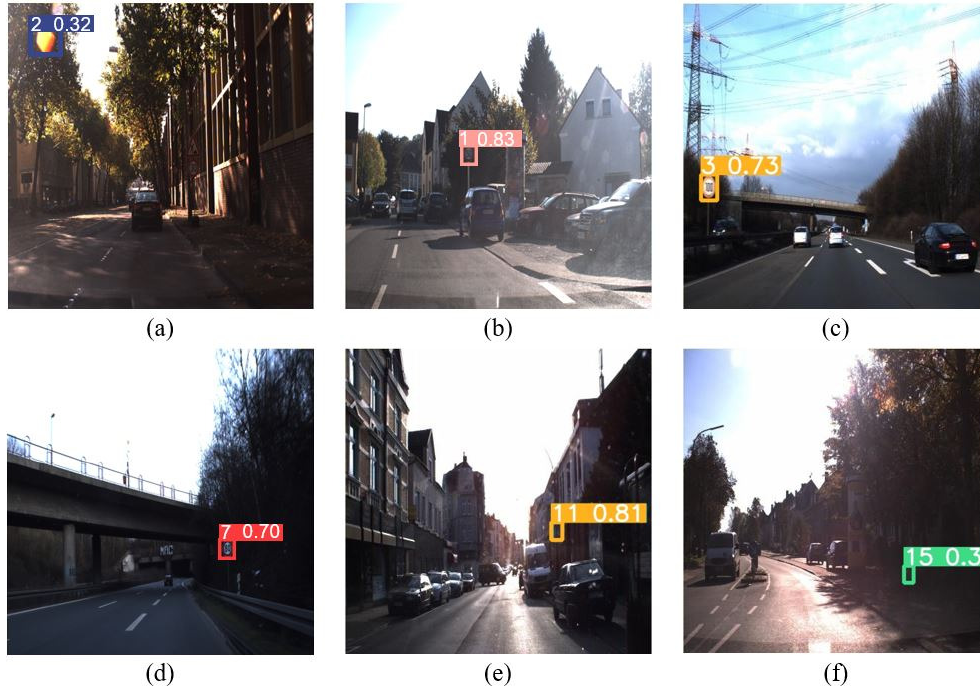
Figure 11. False cases of traffic sign recognition by FSADD: ( a ) ground truth—1 and 25, ( b ) ground truth—2, ( c ) ground truth—7, ( d ) ground truth—5, ( e ) ground truth—18, and ( f ) ground